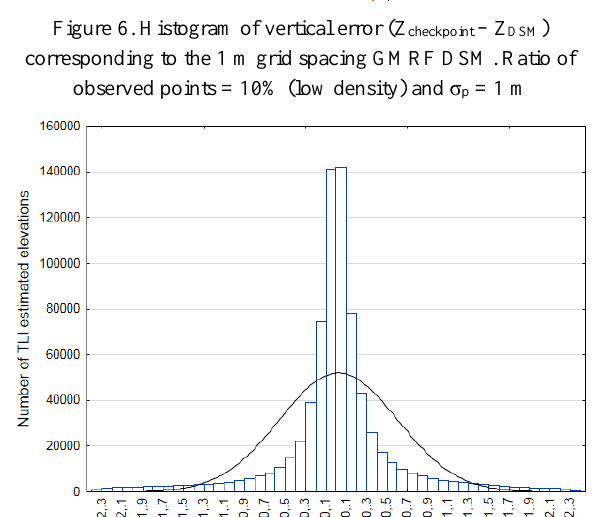
Ratio of observed